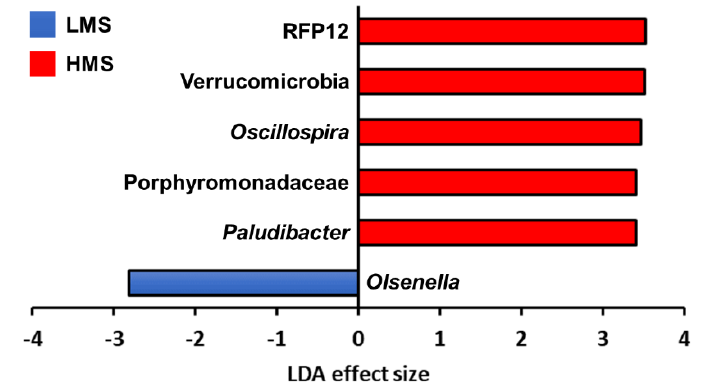
Figure 3. Linear discriminant analysis effect size (LEfSe; differentially abundant bacterial taxa defined by LEfSe analysis) computed between low marbling score (LMS) and high marbling score (HMS) groups.